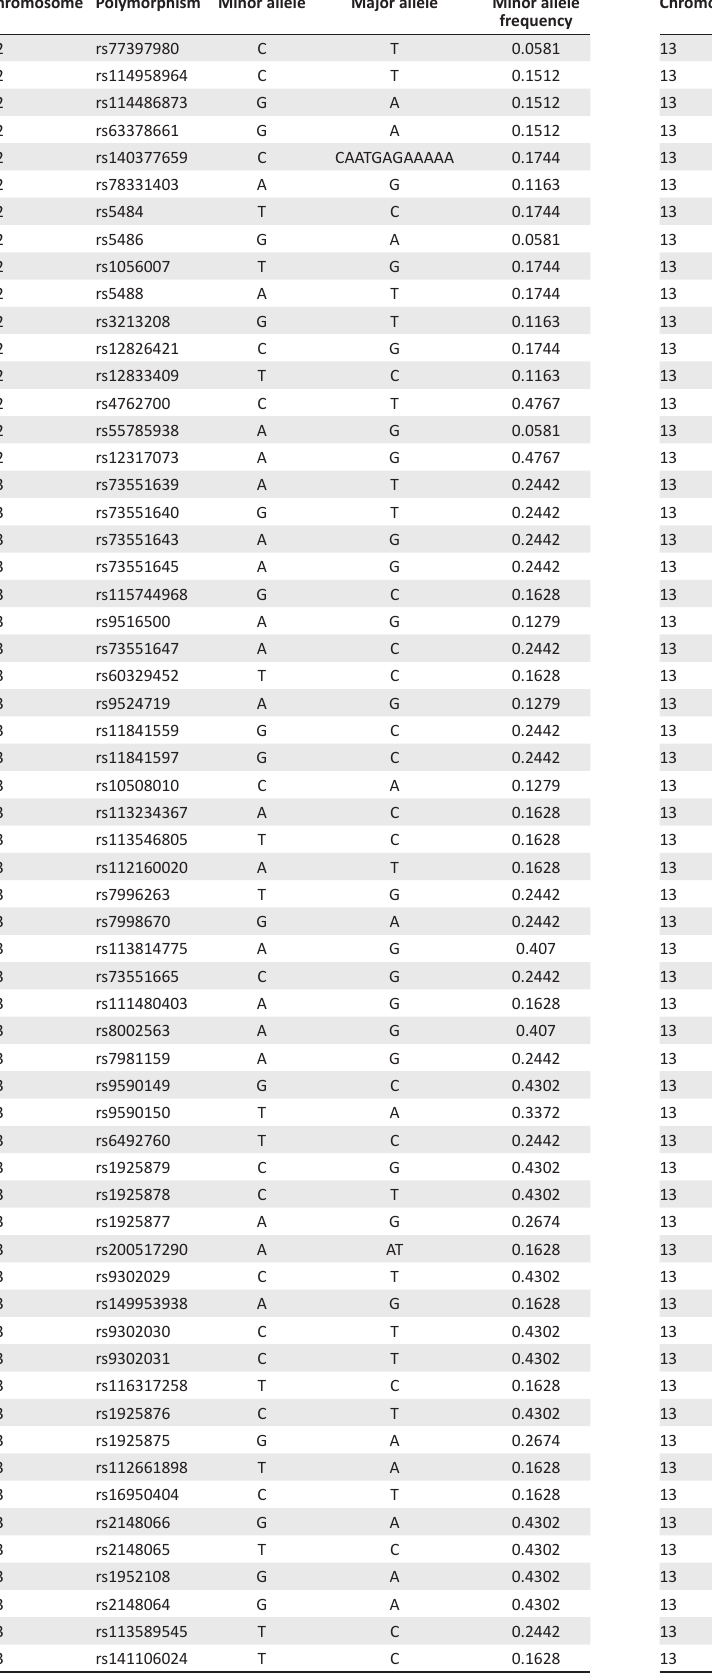
Table 1-A1 continues on the next page →Table 1-A1 continues in the next column